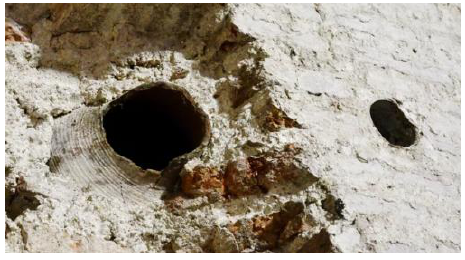
Figure 6. The clay vessels in Kalozha Church.